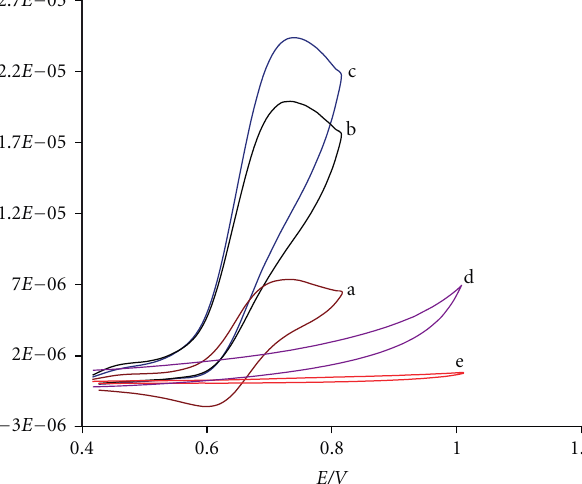
Figure 2: Cyclic voltammograms of (a) 400 μ M CHP at the surface of MWCNTPE; (b) 400 μ M CHP at the surface of CPE in the presence of 200 μ M Hcy; (c) 400 μ M CHP at the surface of MWCNTPE in the presence of 200 μ M Hcy; (d) 200 μ M Hcy at the surface of MWCNTPE; (e) MWCNTPE in the bu ff er solution. 20mVs − 1 .